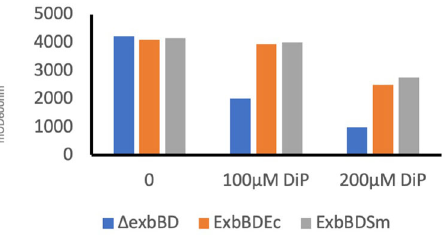
Fig. 2 ExbBD Sm complements ExbBD Ec . Overnight growth in LB broth of E. coli C600 Δ exbBD (pBAD24) (blue), C600 Δ exbBD (pBAD24ExbBD Ec ) (orange), and C600 Δ exbBD (pBAD24ExbBD Sm ) (gray), without (0) or with 100 and 200 µ M iron chelator di-pyridyl (DiP). One representative experiment is shown. The vertical axis represents mDO 600nm absorbance